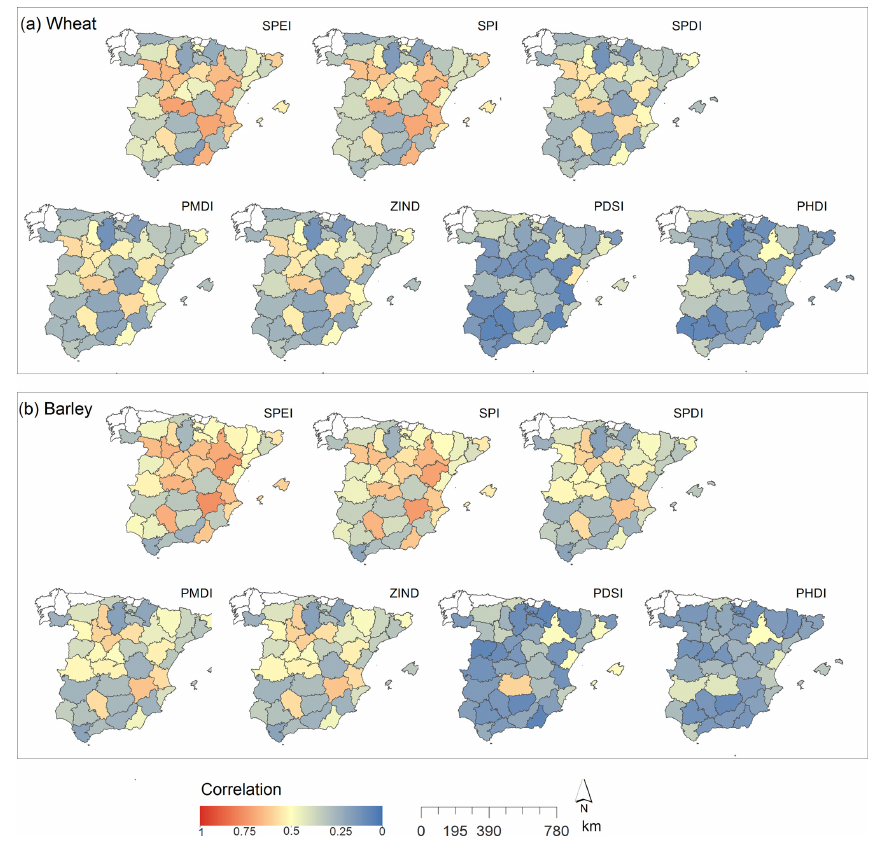
Figure 4. Spatial distribution of the highest correlation coefficients between the drought indices and the wheat (a) and barley (b) yields at the provincial scale, independently of the